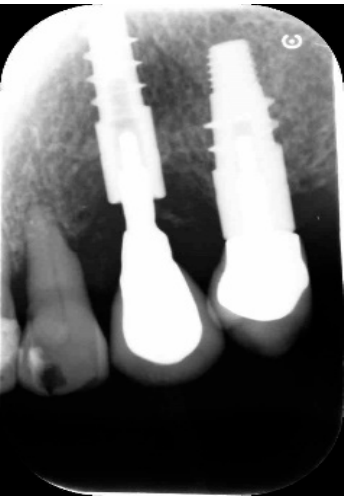
Figure 7. Endoral X-ray taken 12 months after treatment.